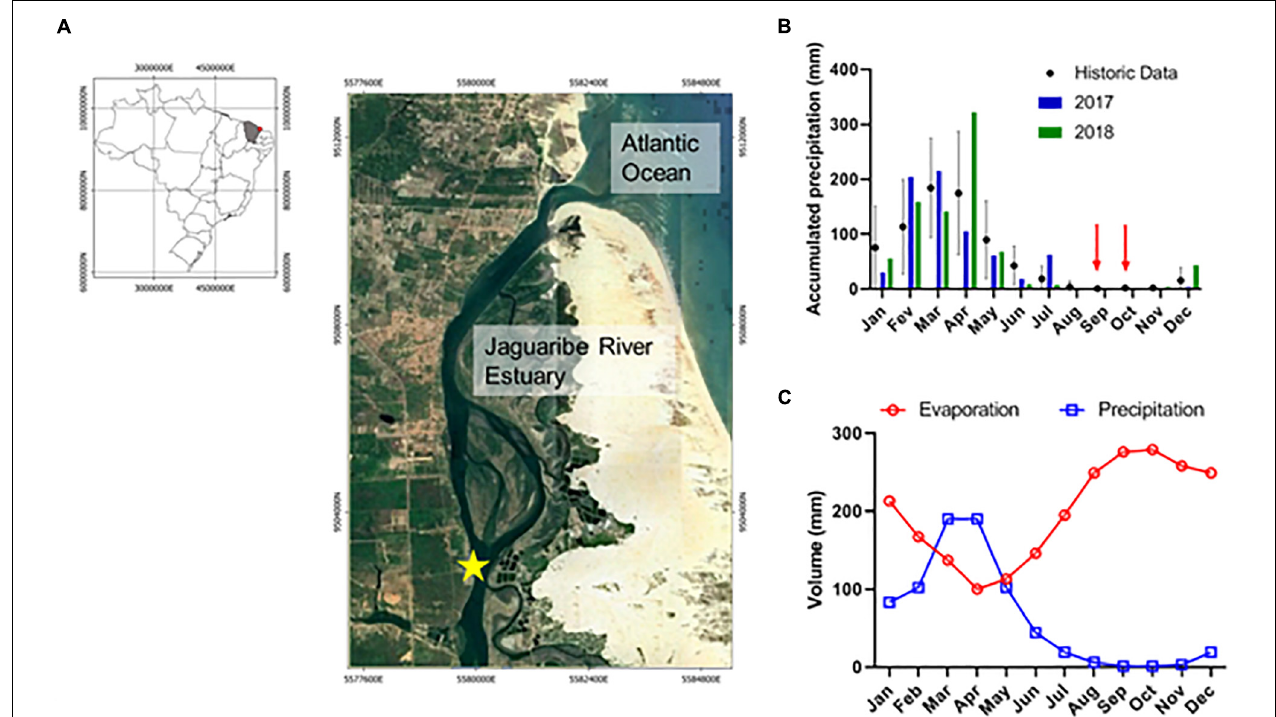
FIGURE 1 | (A) Study area in the Jaguaribe River Estuary (JRE), Ceará, NE Brazil; (B) annual precipitation during the study period; (C) annual evaporation and precipitation over the study area.